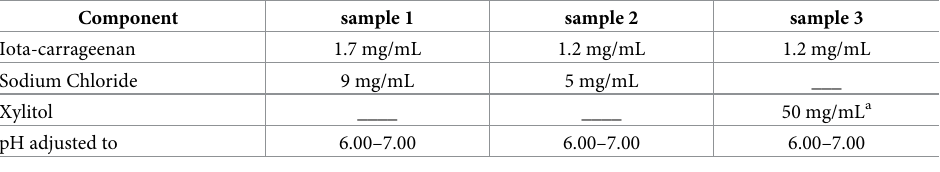
Table 1. Composition of samples containing